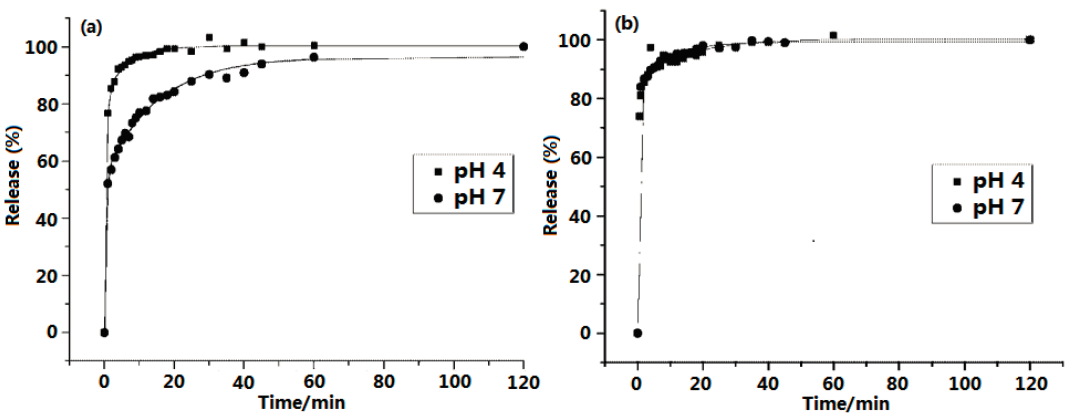
Figure 3. Release profiles for ( a ) diclofenac at pH 4 and pH 7 and ( b ) gemfibrozil at pH 4 and pH 7. Reprinted with permission from [57] (Copyright 2001 Royal Society of Chemistry).